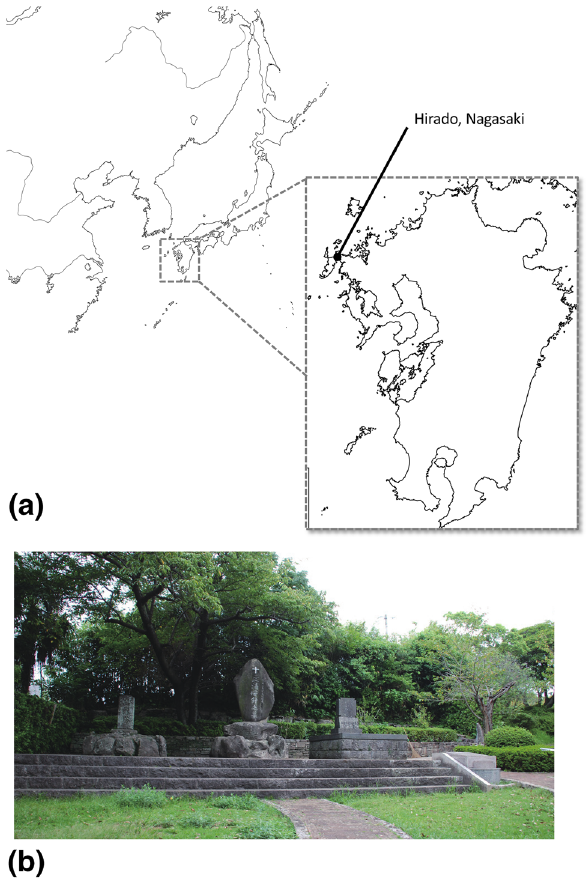
Figure 1. ( a ) A map showing the location of Hirado City, Nagasaki Prefecture, Japan, where Miura Anjin’s grave is situated. Base map sourced from https ://www.freem ap.jp. ( b ) An image of the tombstone at Miura Anjin’s